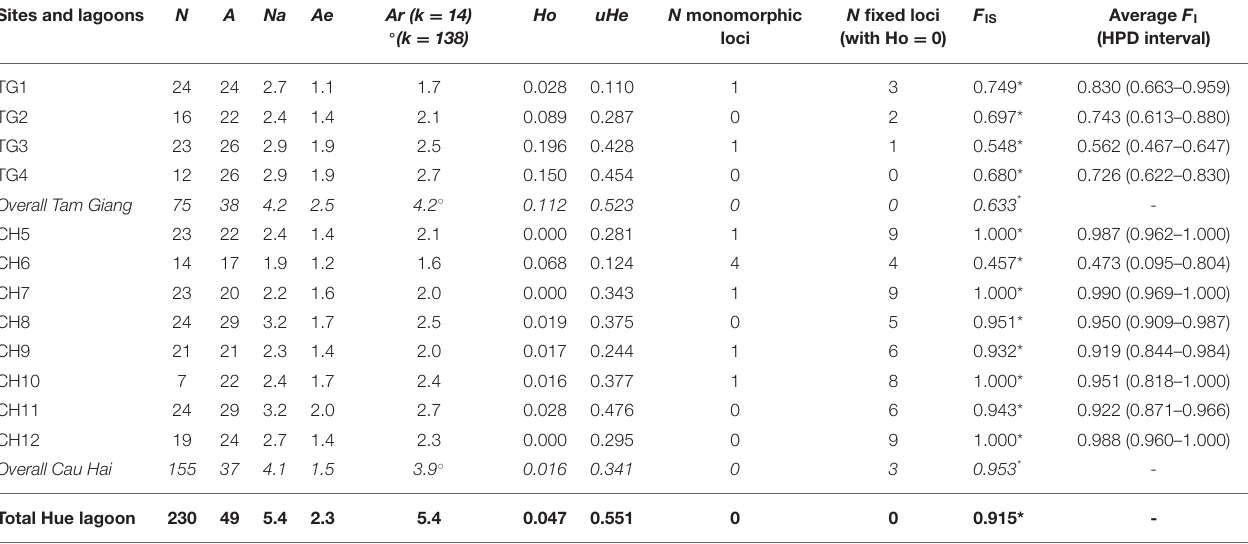
TABLE 2 | Gene diversity measures of 12 Ruppia brevipedunculata sites and over 2 lagoons (TG and CH). Sites and lagoons N A Na Ae Ar (k = 14)